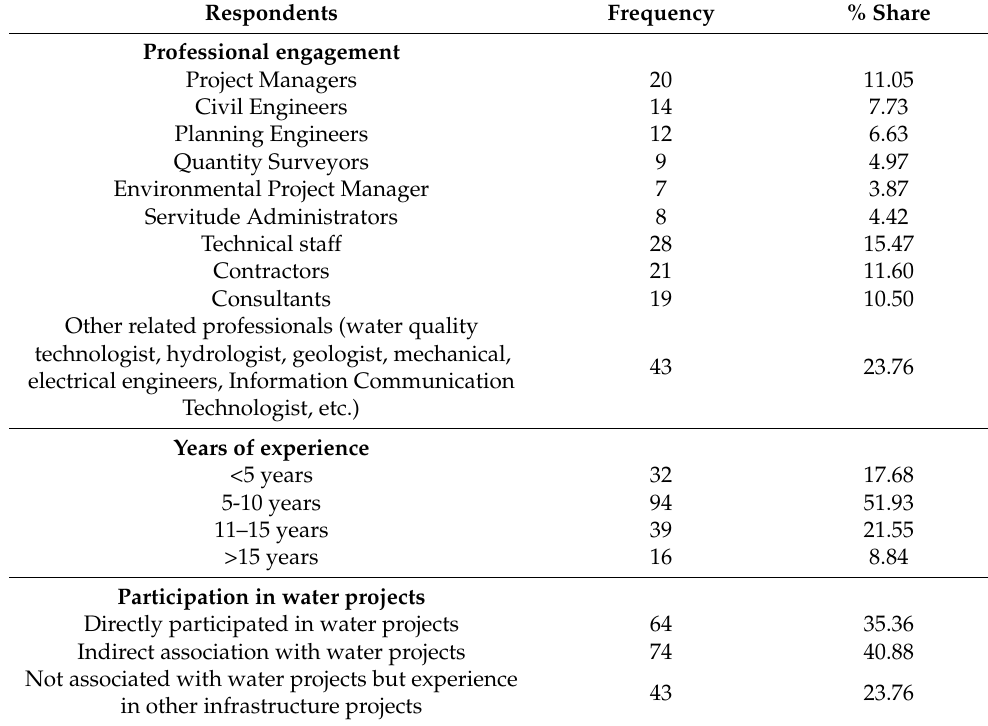
Table 2. Profile of the